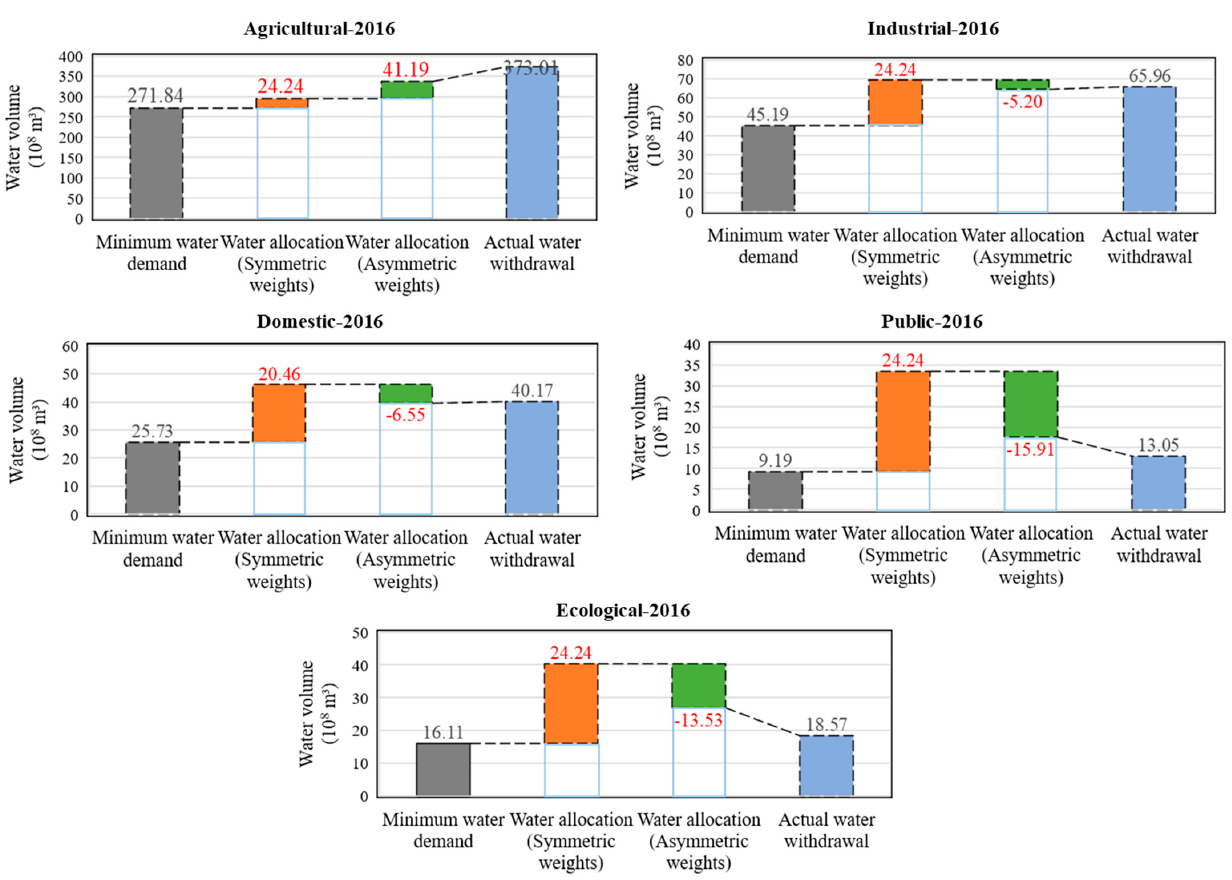
Figure 14. Results of water allocation in 2016 (symmetric and asymmetric).